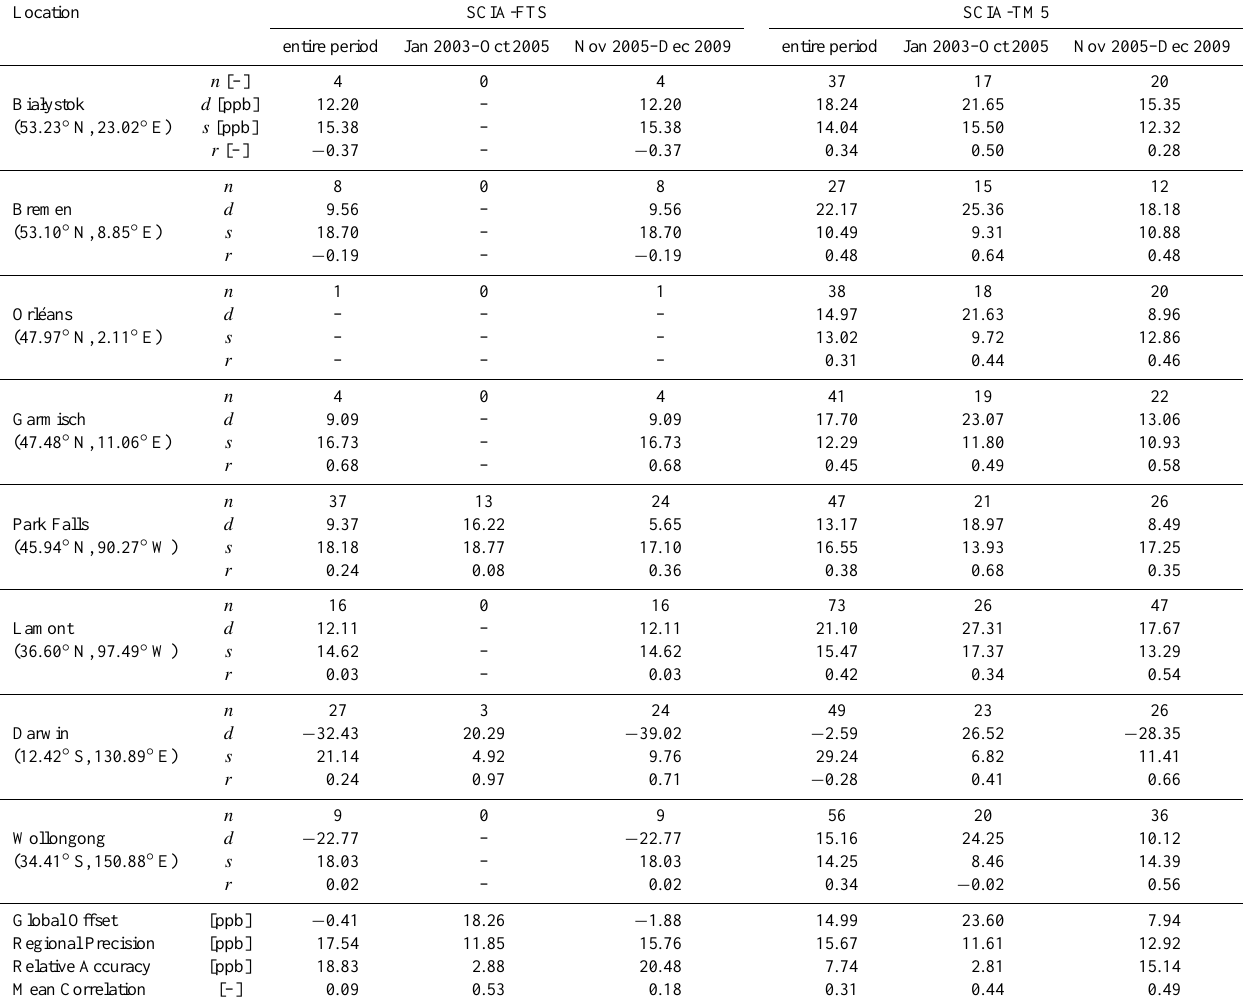
Table 3. As Table 1 but for WFMDv2.0.2 XCH 4 compared to FTS and TM5-4DVAR. The results are also divided in the two periods before and after the pixel mask change at the beginning of November